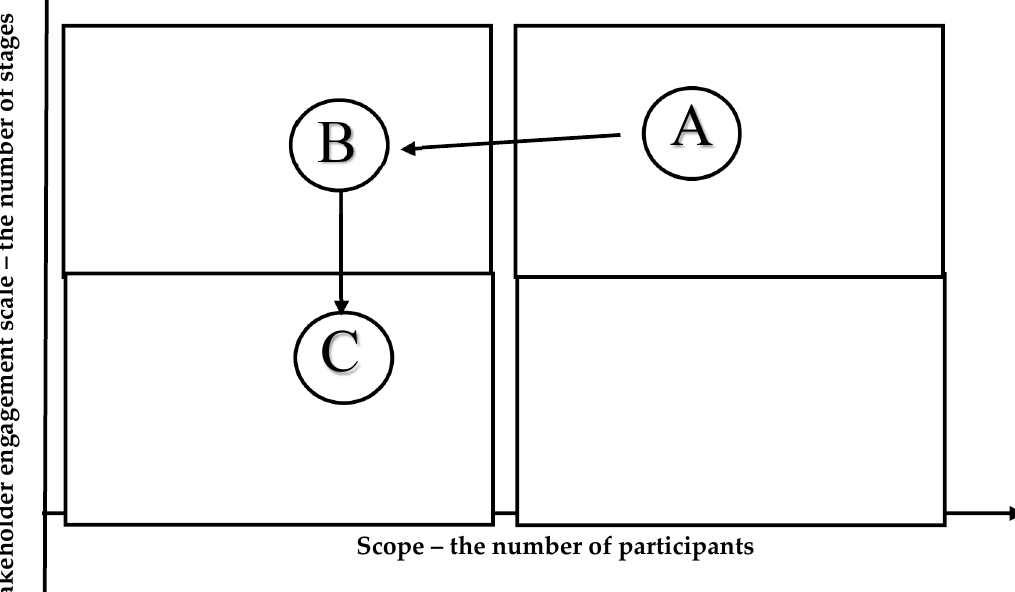
Figure 2. Changes in the scale of stakeholder engagement depending on the type of activity. A—unpaid mission-related activity, B—paid mission-related activity, C—business